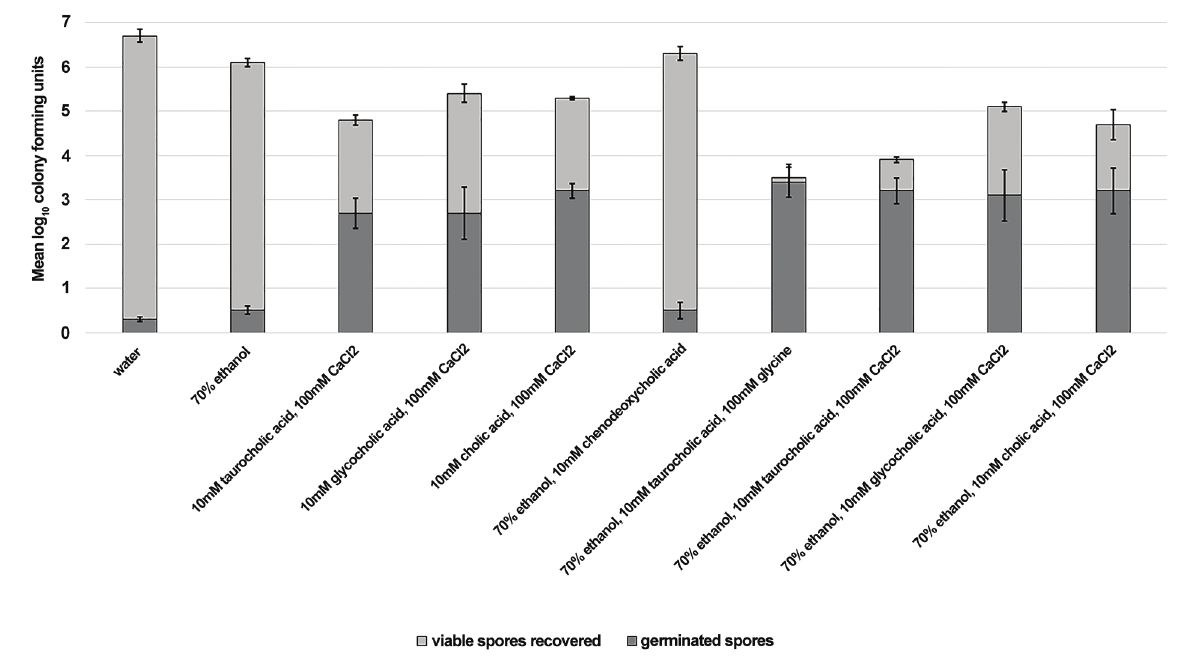
Figure 2. Reduction of Clostridium difficile spores is enhanced in an ex vivo porcine skin model by applying germinants in an ethanol matrix. Sections of porcine skin (1 cm 2 ) were inoculated with 7 log colony forming units (CFU) of C. difficile R20291. Then 50 µ L of test solution was applied once and 10 rubbed into each skin section until absorbed. After 24 hours of incubation at room temperature, the spores were recovered from skin sections and the log CFU of viable and germinated spores was determined. The 10 means of data from triplicate experiments are presented. Error bars indicate standard